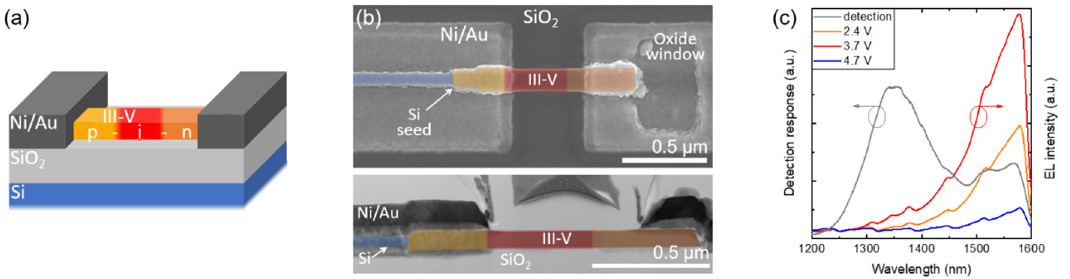
Figure 6. ( a ) The last step in addition to the process flow in Figure 1 consists of depositing Ni/Au contacts. The grown III-V material for this device is a p-i-n heterostructure, as indicated in ( b ) by the false-colored top-view SEM and cross-sectional TEM. The Si seed for growth nucleation is clearly visible underneath the deposited contact. ( c ) Spectral response of the monolithic InGaAs photodetector in reverse bias (detection) and forward bias (emission), on different scales. ( b , c ) are adapted with permission from [34].